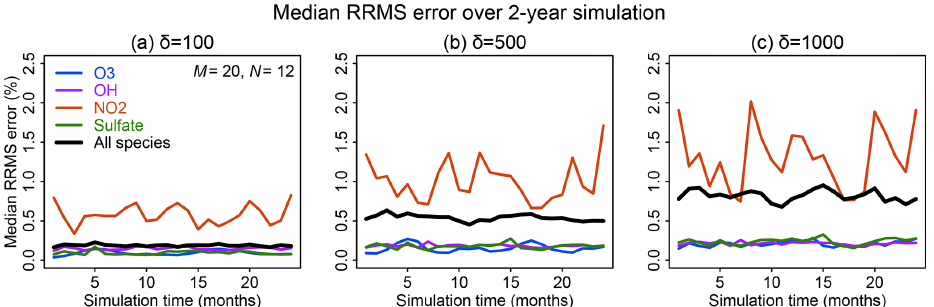
Figure 6. Accuracy of the adaptive reduced chemistry mechanism algorithm over a 2-year GEOS-Chem simulation (see text). The accuracy is measured by the 24h mean RRMS error on the end day of each month relative to a simulation including the full chemical mechanism. Rate thresholds δ of (a) 100, (b) 500, and (c) 1000moleculescm − 3 s − 1 are used to partition the fast and slow species in the reduced mechanism. Results are shown for the median RRMS across all 228 species of the full mechanism and more specifically for ozone, OH, NO 2 , and sulfate.